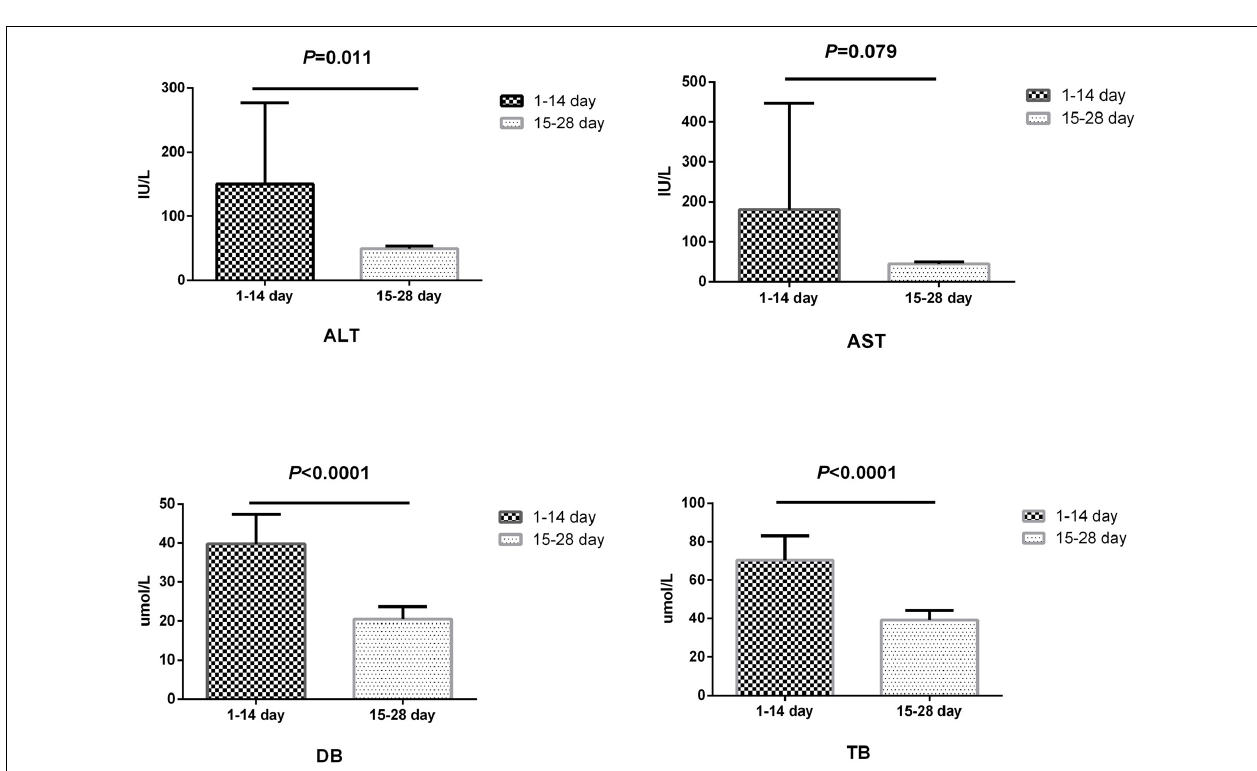
FIGURE 2 | Differences of convalescence phase and stabilizing phase of liver function. ALT, glutamic-pyruvic transaminase; AST, glutamic oxalacetic transaminase; TB, total bilirubin; DB, direct bilirubin. P < 0.05 was considered significant.